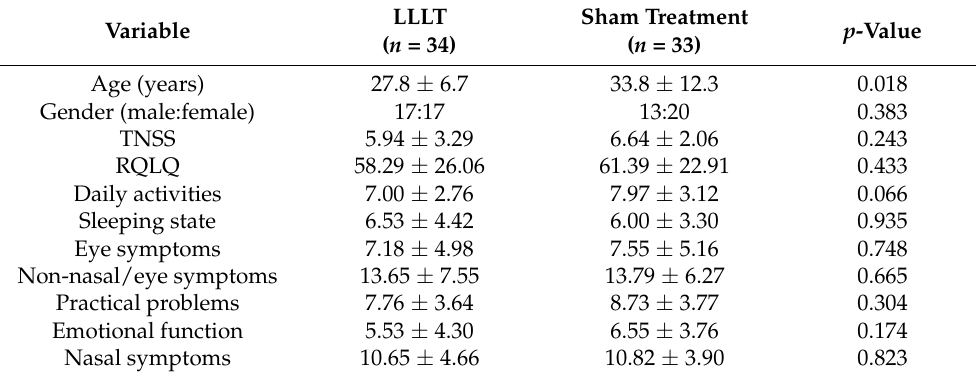
Table 3. Comparison of participant characteristics in the two groups